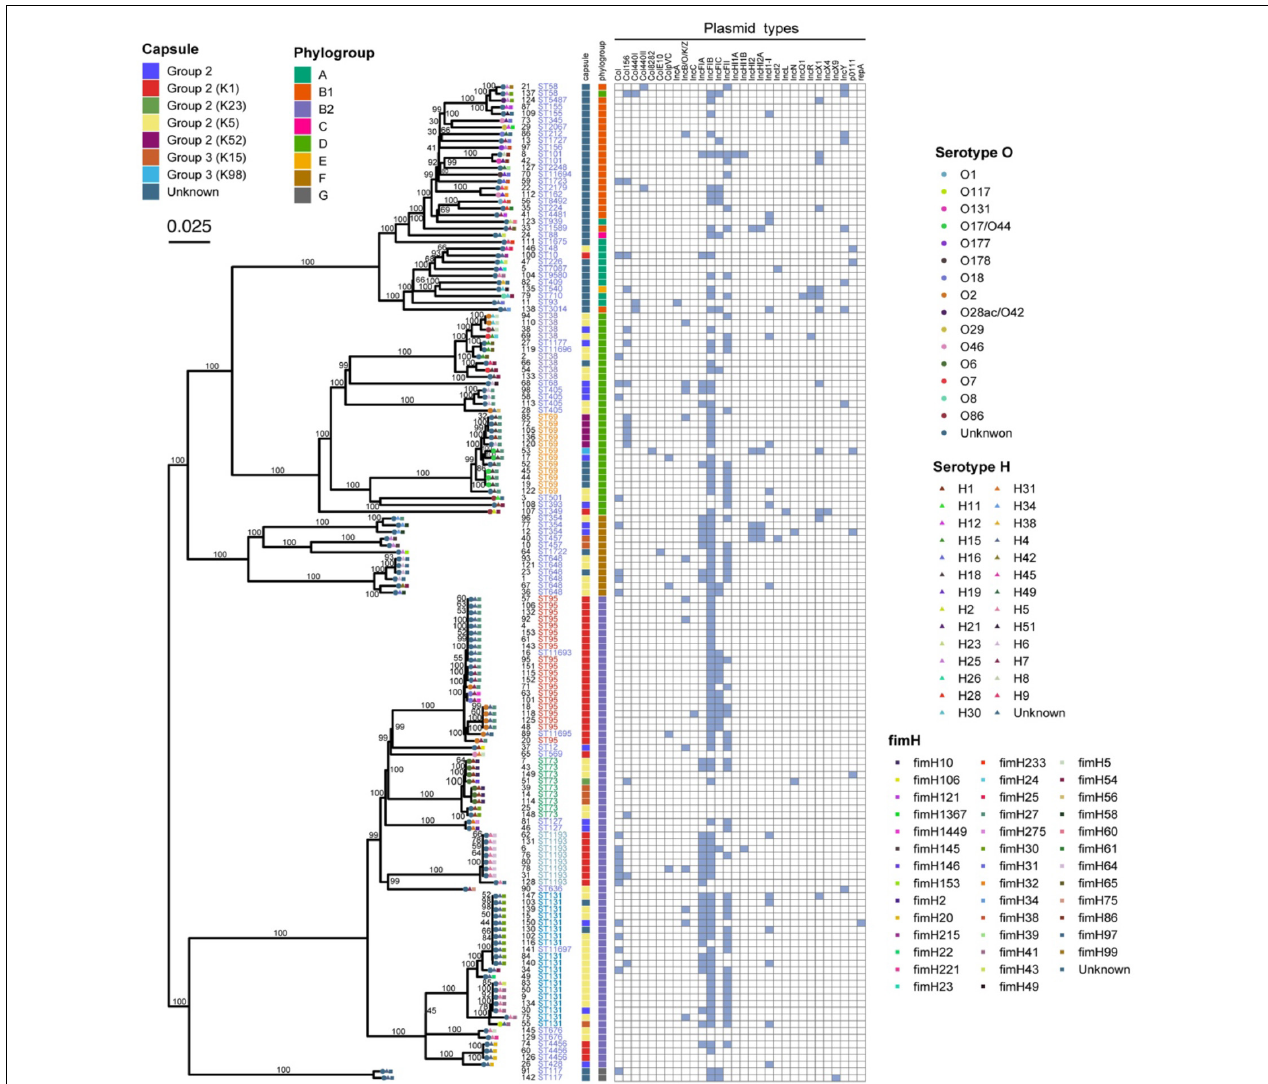
FIGURE 2 | Maximum likelihood phylogenic analysis of 148 E. coli isolates from patients with EC-COBSI based on